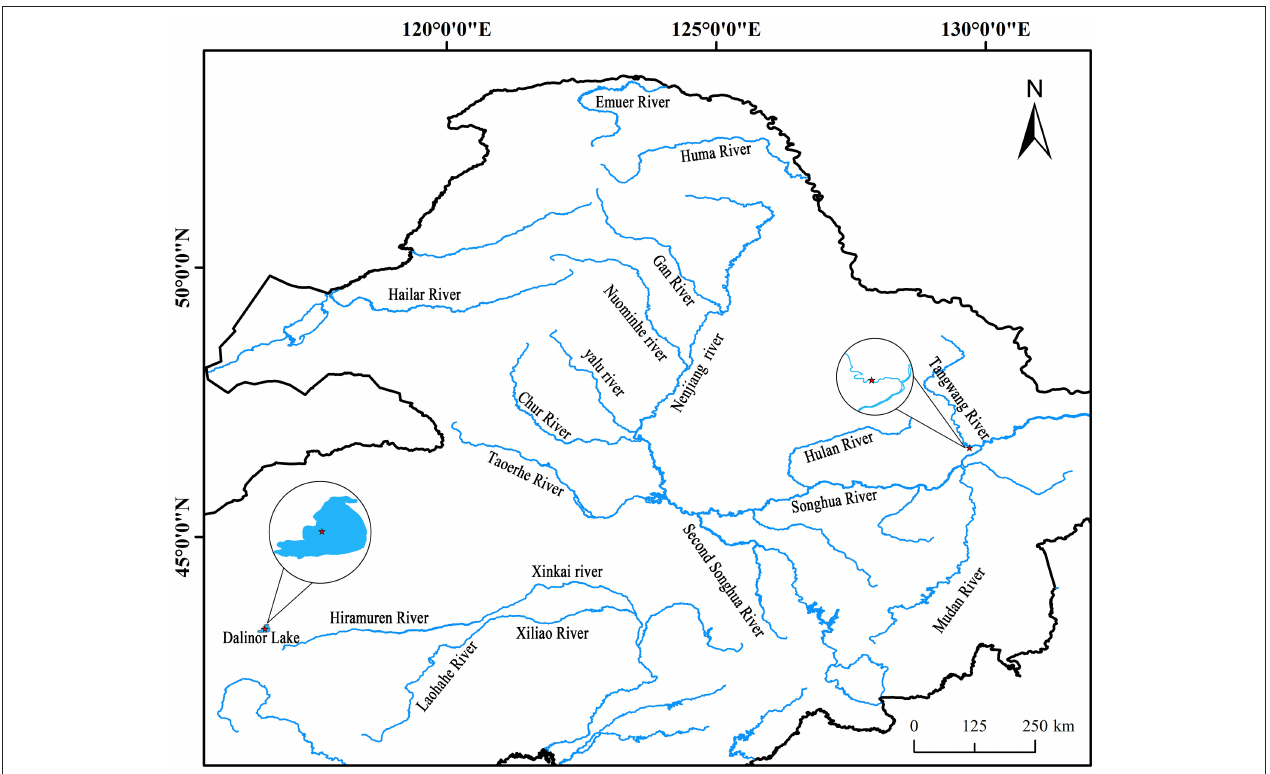
FIGURE 1 | Geographical distribution of the sampled populations. Cycles represent the sampling locations and include alkaline water species (AW) from the Dali Nor lake and freshwater species (FW) from the Tangwang